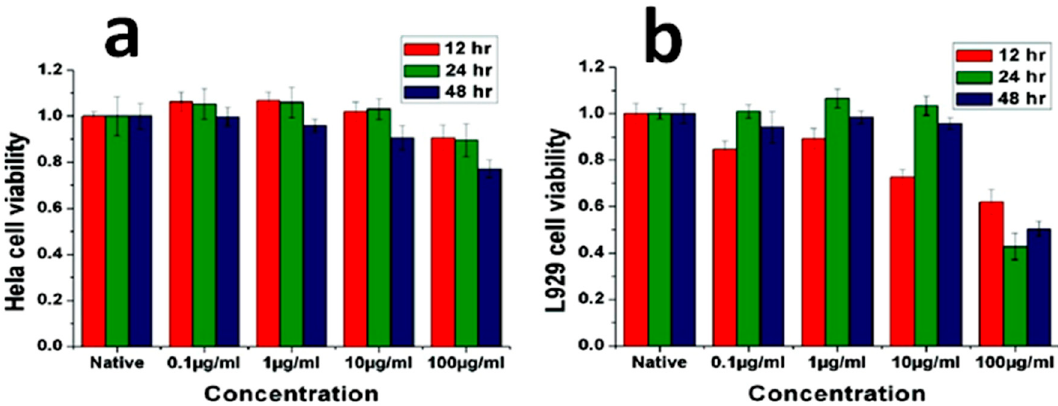
Figure 3. Cell viability tested by the MTT (3-(4,5-dimethylthiazol-2-yl)-2,5-diphenyltetrazolium bromide) method as a function of ZnO NW concentration and time. ( a ) Cell viability of the HeLa cell line in the MTT test, cultured with different concentration of ZnO NWs for 12 h, 24 h, 48 h; ( b ) Viability of L929 cell line in the MTT test, cultured with different concentrations of ZnO NWs for 12 h, 24 h, 48 h. Adapted with permission from reference [87]. Copyright (2008) American Chemical Society.